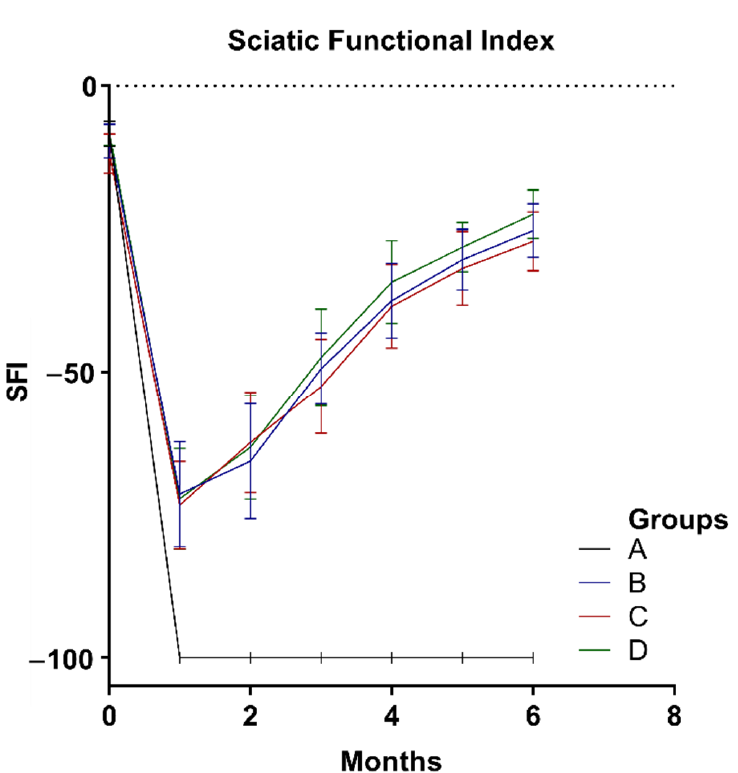
Figure 3. Graph represents sciatic function index (SFI) within 6 months observation in 1-month intervals obtained for examined groups: (A) nerve gap, (B) autograft, (C) P(LLA-CL)-COL-PANI conduit, (D) P(LLA-CL)-COL-PANI with ASCs. No statistically significant differences were noted among experimental